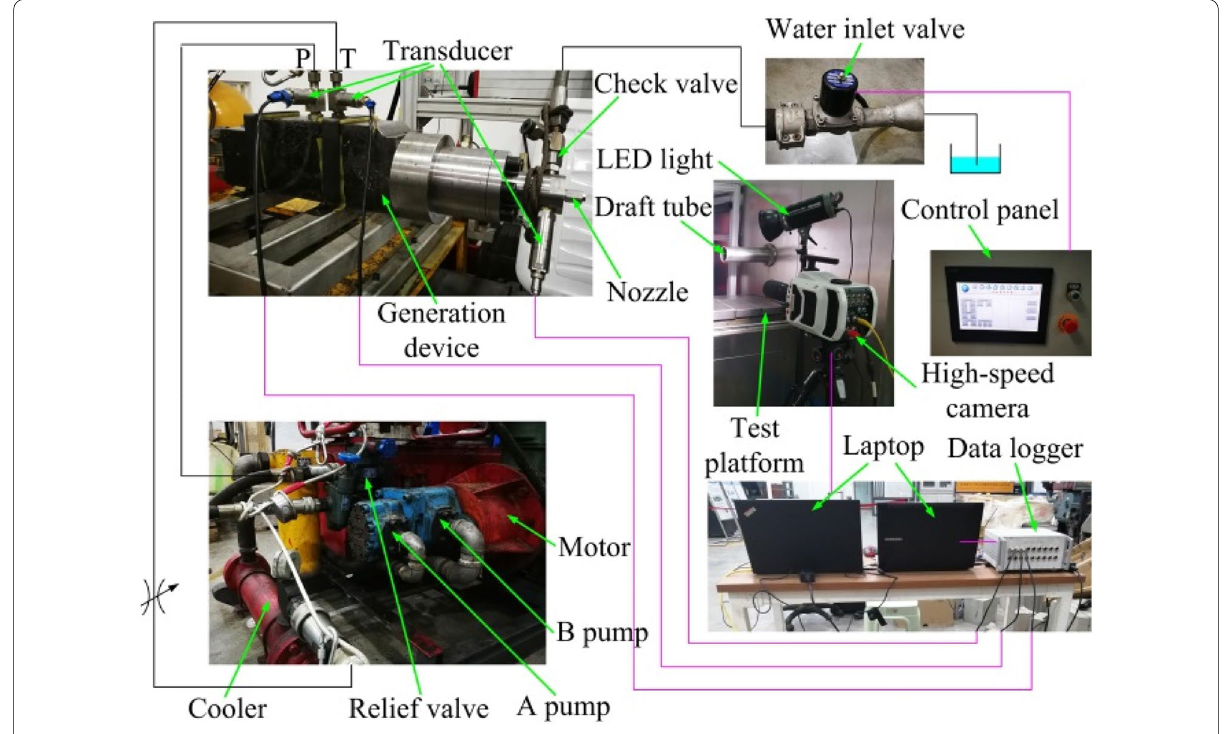
Figure 7 Jet-pressure and morphology test of the SSPWJ